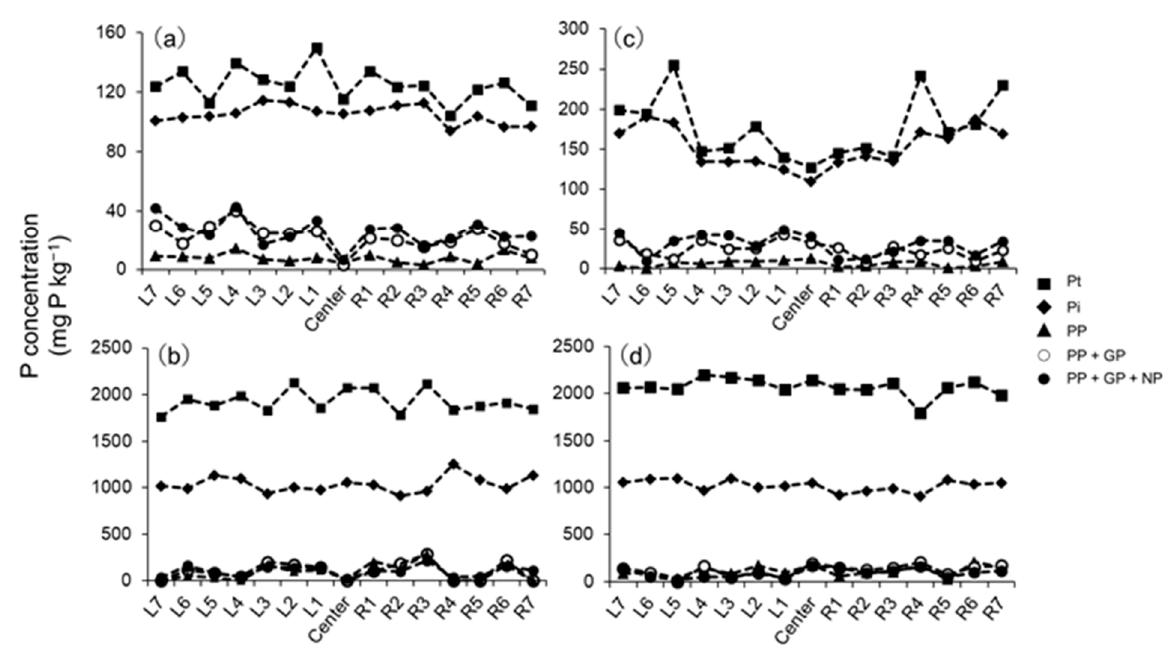
Figure 2. Phosphorus concentrations in ( a ) the NaHCO 3 fraction from mineral fertilizer (NPK) soil, ( b ) the NaOH fraction from NPK soil, ( c ) the NaHCO 3 fraction from NPK + compost soil, and ( d ) the NaOH fraction from NPK + compost soil in the rhizobox system where barley was cultivated for 5 weeks. PP: acid phosphatase Type IV-S from potato; GP: acid phosphatase Type I from wheat germ; and NP: nuclease P1 from Penicillium citrinum .